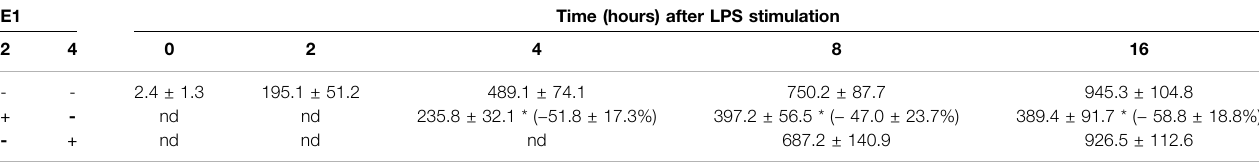
TABLE 3 | Time course of TNF- α release (pg/ml) after LPS stimulation and effect of post-treatment with E1. E1 Time (hours) after LPS stimulation